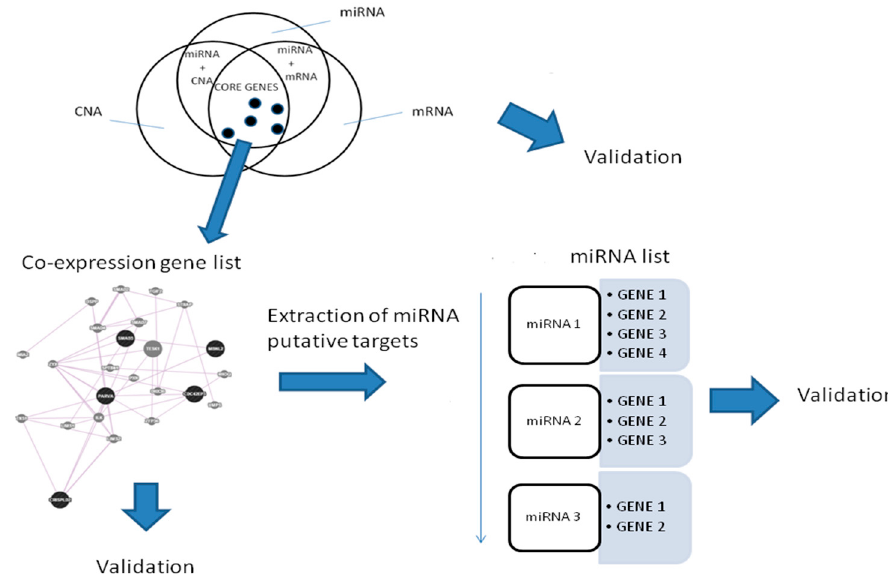
Figure 8. Workflow of the proposed analysis.